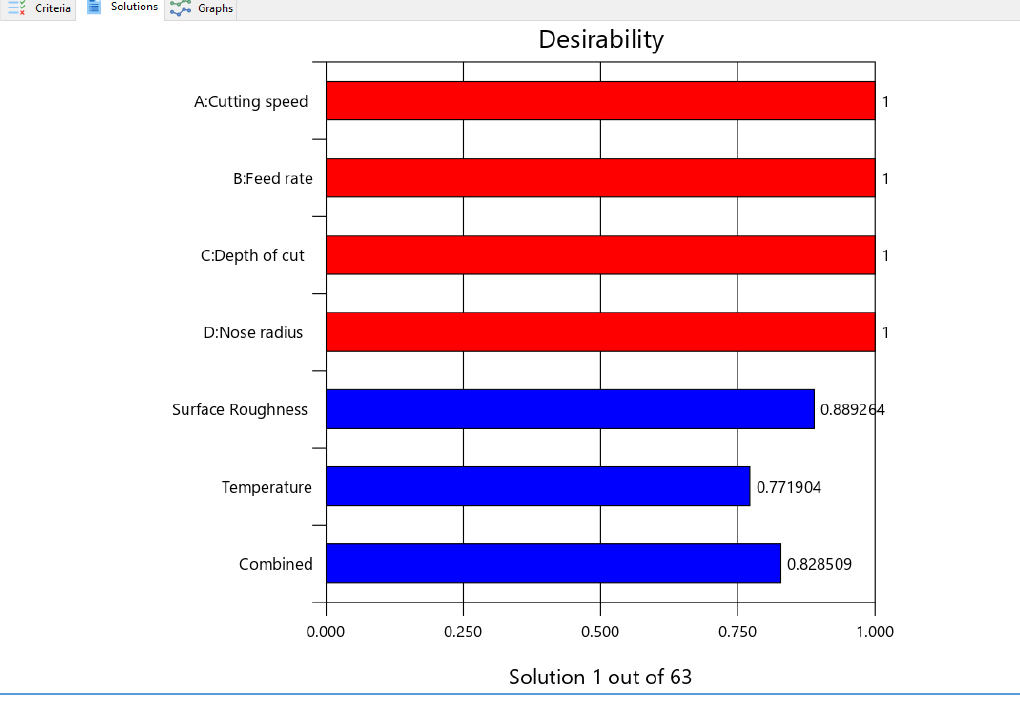
Figure 8. Desirability bar graph for combined optimization. Table 8. Optimum values during turning of aluminum.